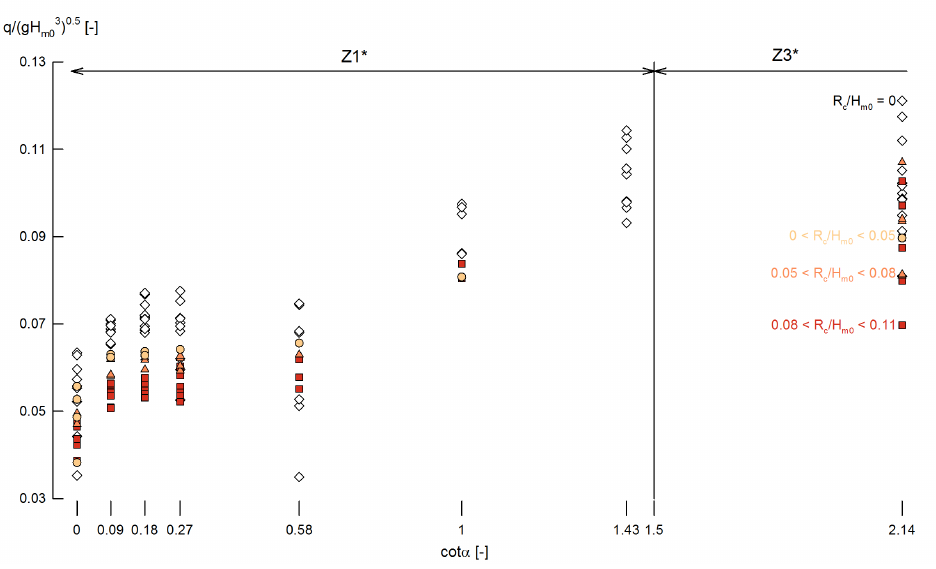
Figure 8. Dimensionless average wave overtopping q / for very small and zero relative crest freeboards (0.11 ≥ R c / H m 0 ≥